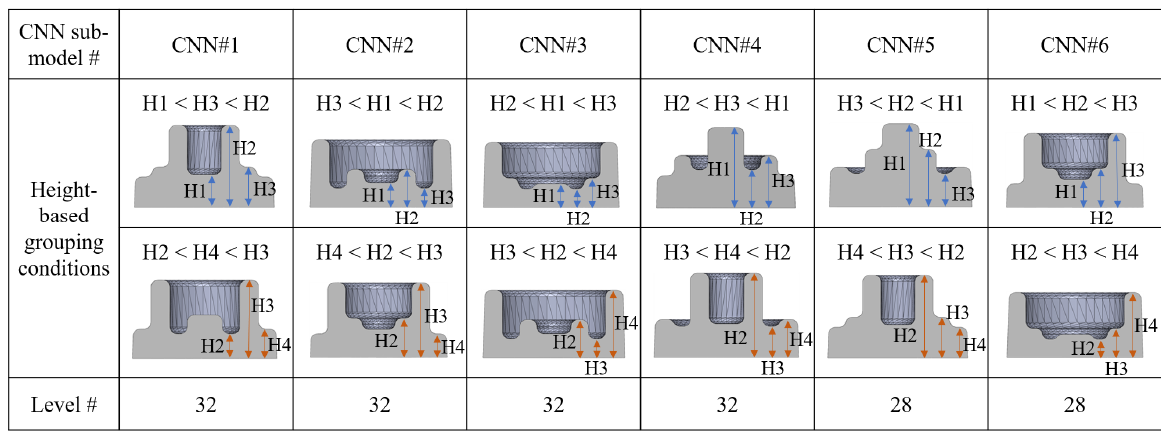
Figure 7. Geometry-based grouping procedure for the six CNN sub-models with shape examples.